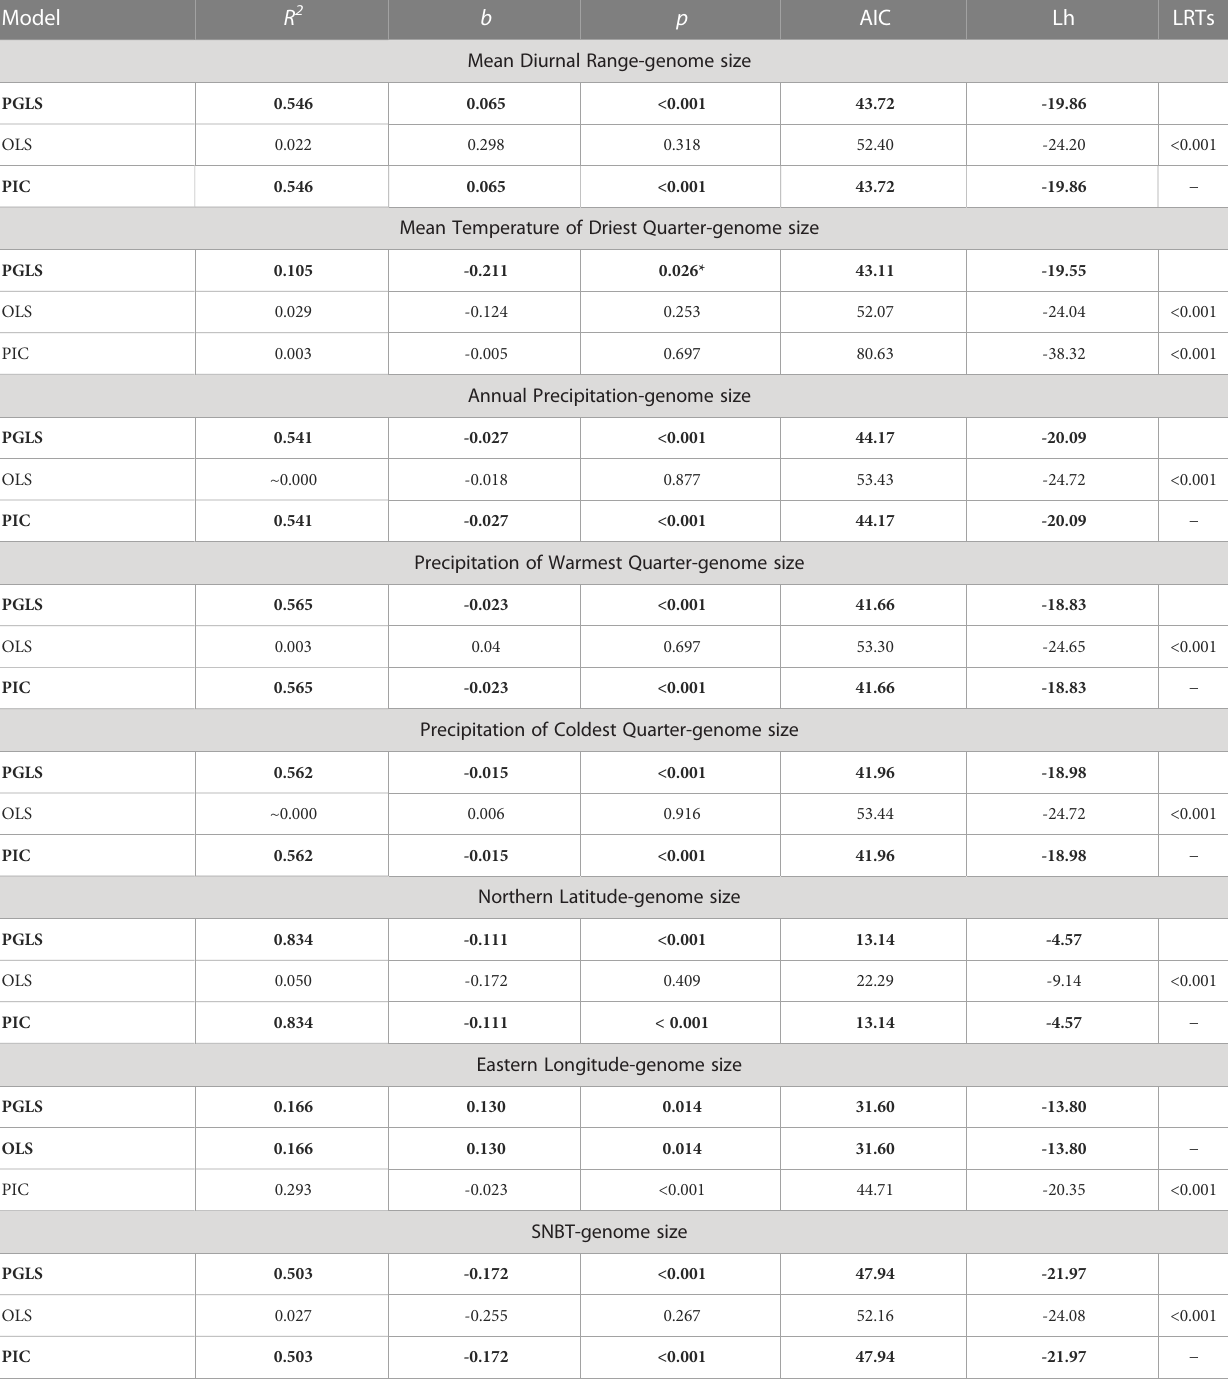
TABLE 3 Summary of associations between Eragrostis genome sizes (2C, pg) and environmental factors tested by three regression models.